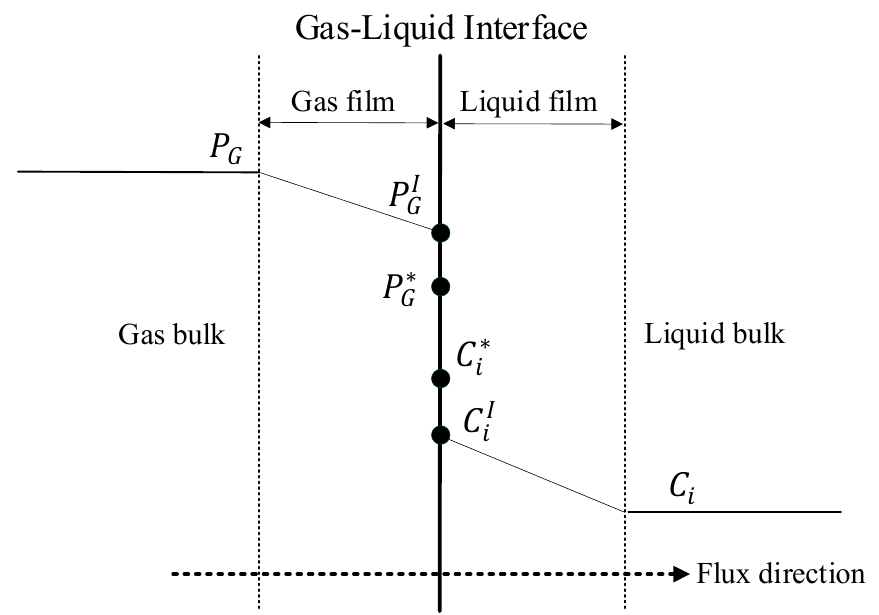
Figure 5. Concentration profiles based on the two-film model [34], * refers to the conditions at the equilibrium state.